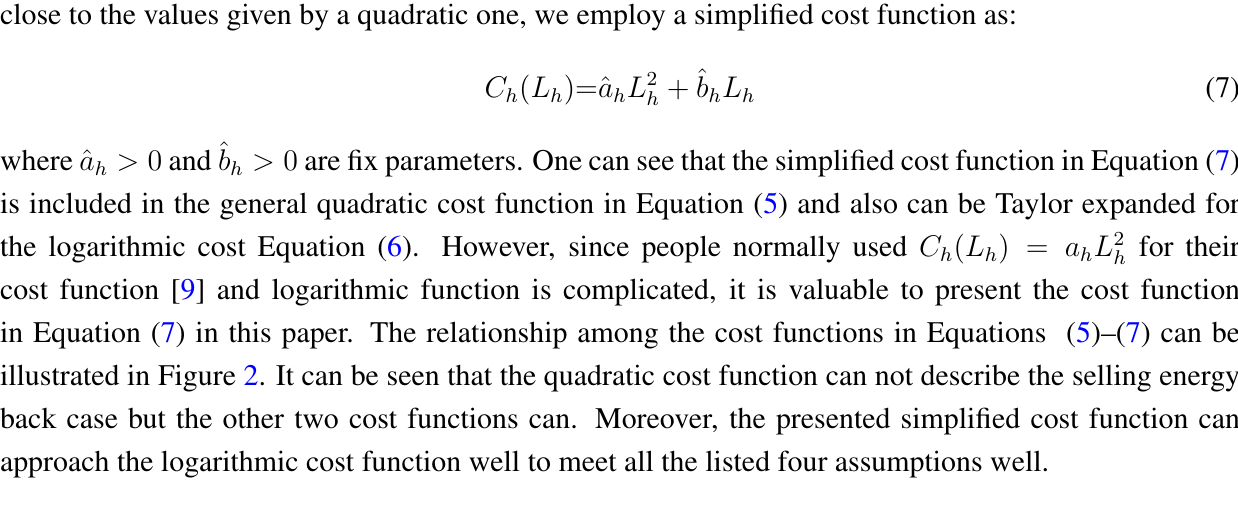
Figure 2. Illustration of cost